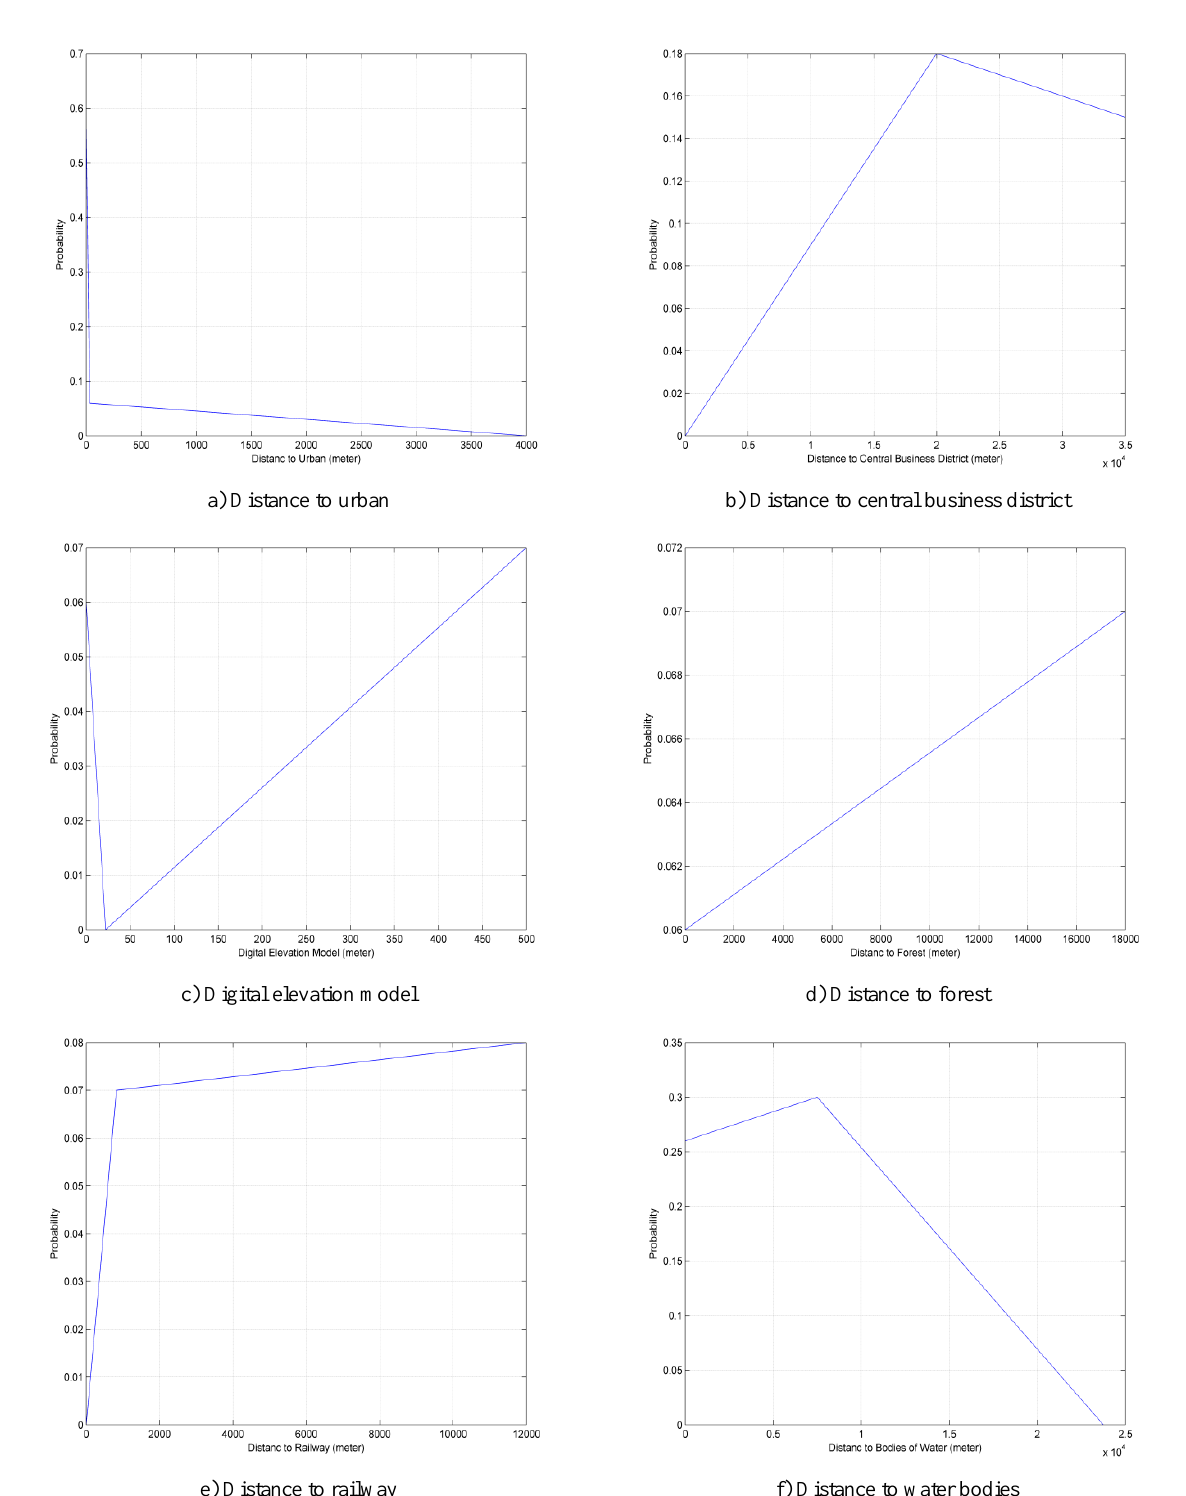
Figure 2. Basic functions of MARS for significant